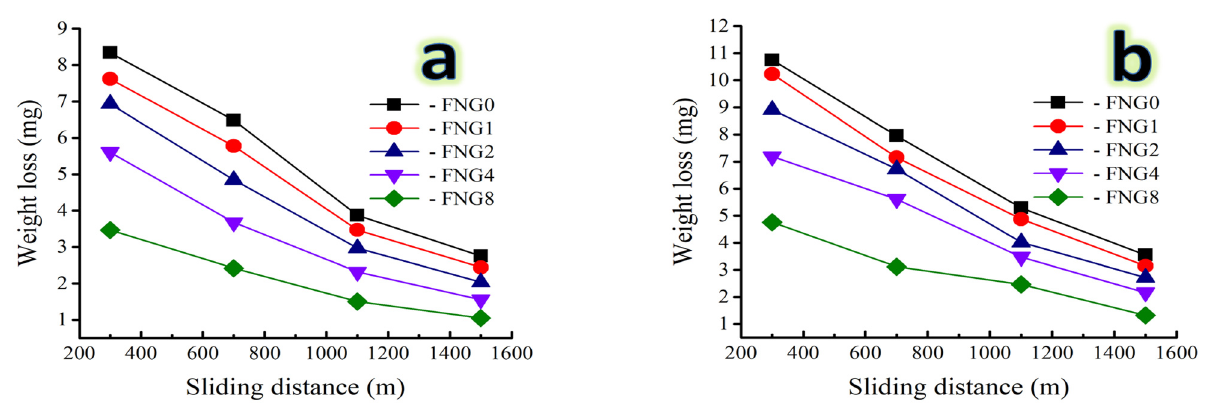
Figure 13. Weight loss of the Fe alloy and its nanocomposites as a function of the sliding distance at a load of ( a ) 10 N and ( b ) 30 N.